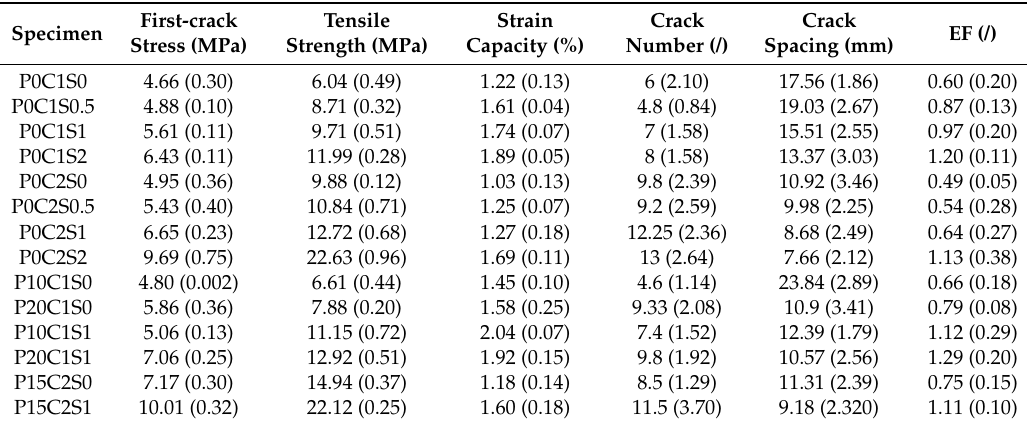
Table 4. Mechanical properties of uniaxial tensile tests.